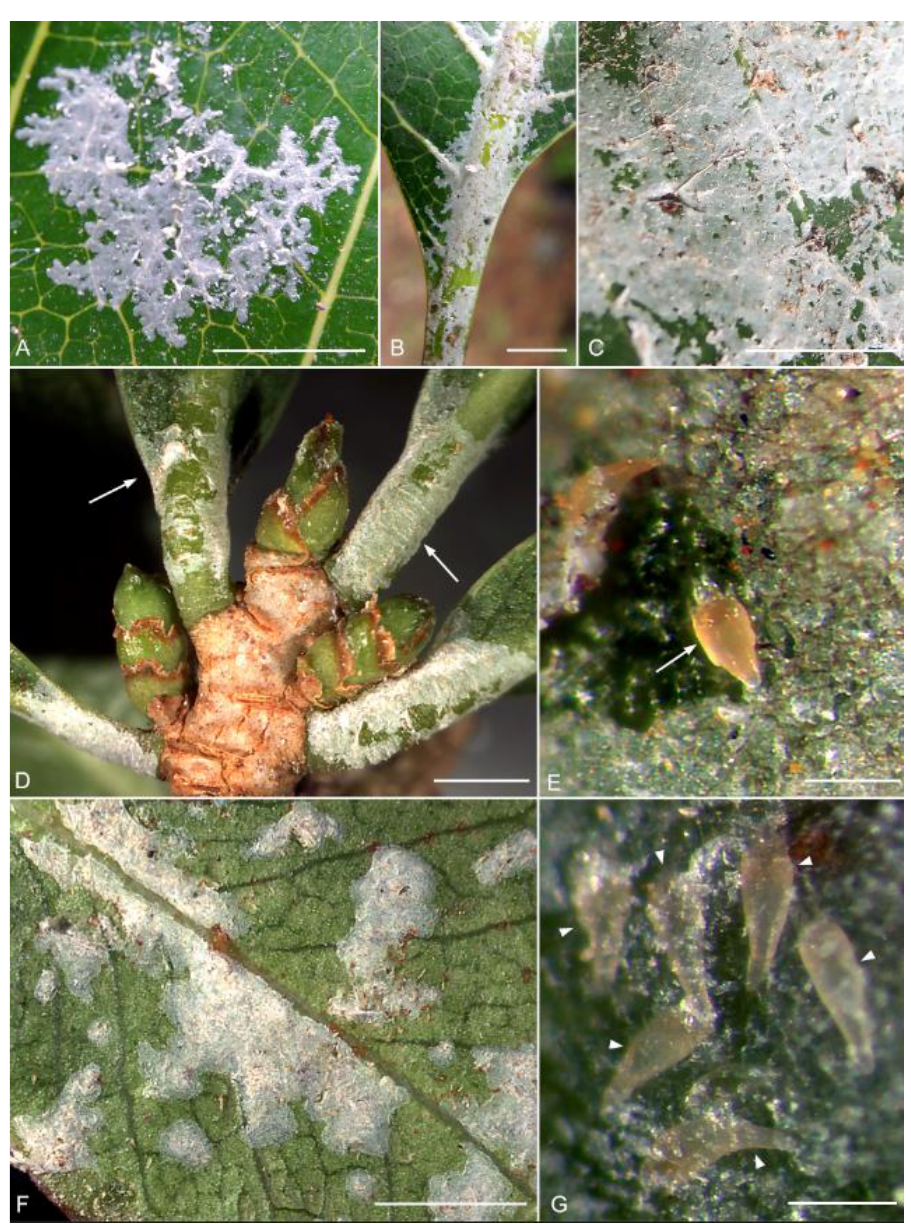
Figure 1. Microphotographs of the web nests of three eriophyoid species from South Africa. ( A – C ) — young ( A , B ) and older ( C ) nests of Cisaberoptus kenyae on mango leaves; ( D ) — webbing of Aberoptus platessoides (arrows) on petioles of leaves of Ochna pretoriensis ; ( E ) — a female of A. platessoides (arrow) in the nest, web partially removed; ( F ) — webbing of Aberoptus schotiae n. sp. on lower leaf surface of Schotia brachypetala ; ( G ) — a group of web-spinning females of A. schotiae n. sp. (arrowheads) under web. Scale bars: ( A – D , F ) = 0.5 cm; ( E , G ) = 100 μm.